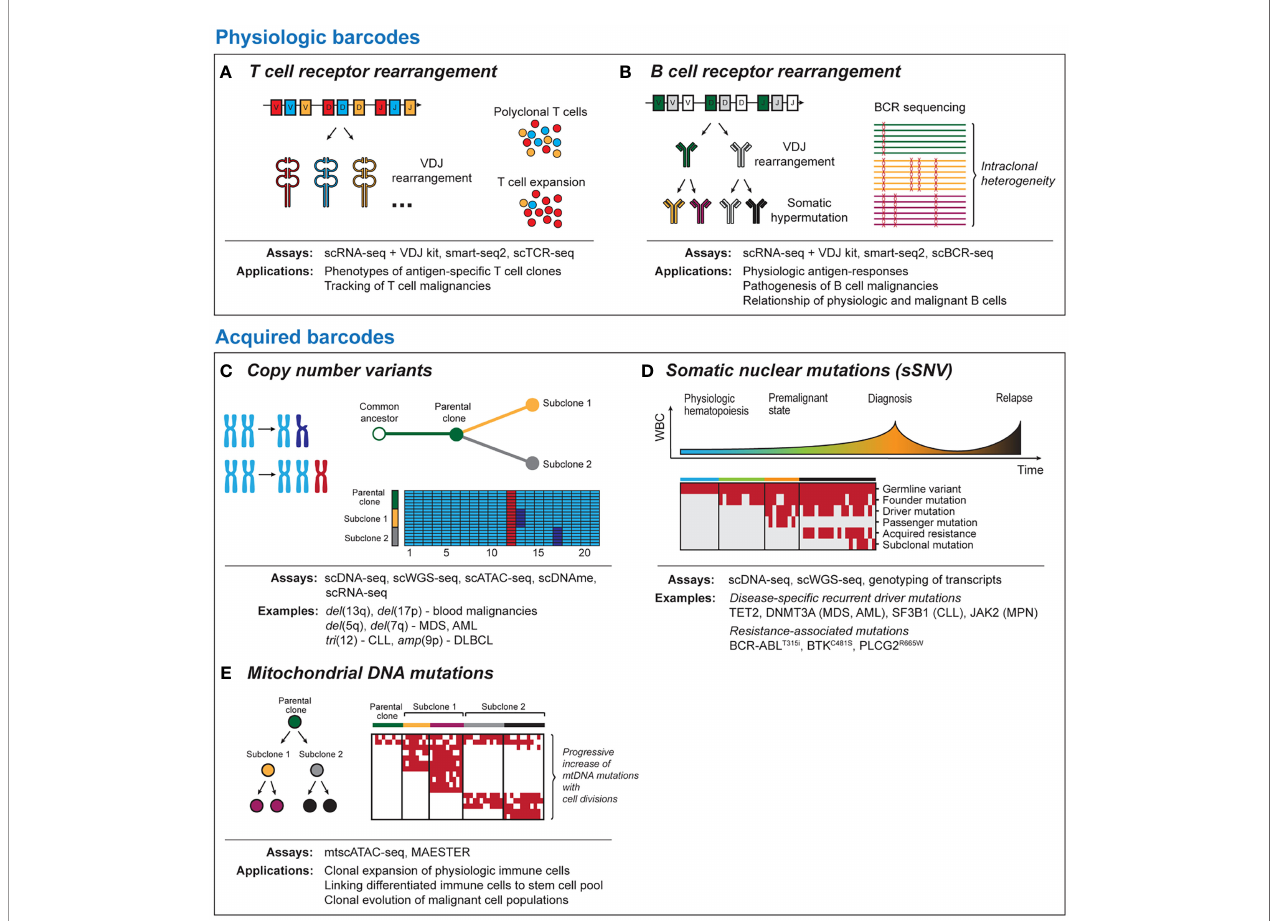
FIGURE 1 | Tool kits for lineage tracing with single-cell sequencing. Physiologic barcodes (A) T cell receptor (TCR) sequencing detects clonal expansion of T cells based on VDJ rearrangement and junctional diversi fi cation. TCR can help to identify and phenotype antigen-speci fi c T cells or track malignant T cells. (B) B cell receptor (BCR) sequences arise due to VDJ rearrangement and ongoing somatic hypermutation. BCR can provide insight into physiological antigen responses and intraclonal heterogeneity in post-germinal B cell malignancies. Both BCR and TCR are best read out with RNA-based single-cell platforms due to the high number of BCR/TCR mRNA templates per cell. Acquired barcodes (C) Chromosomal copy number variants (CNV) are common aberrations in blood malignancies. CNV can provide robust signals with DNA- and RNA-based sequencing platforms that allow to dissect subclonal structure of cancer and can be detected using most single- cell sequencing platforms. (D) Somatic nuclear mutations (single somatic-nucleotide variant, sSNV) can track clonal evolution in cancer longitudinally. Different classes of somatic mutations are distinguished such as germline variants, cancer initiating mutations, mutations associated with therapeutic resistance and sporadic mutations unrelated to the disease pathogenesis. (E) Mitochondrial DNA mutations are progressively acquired as cells divide. This allows to link physiologic or malignant cells to a common ancestor and to resolve phylogeny. As coverage of mitochondrial transcripts tends to be incomplete, they can be best read out from DNA-based sequencing platforms. scDNA-seq, single-cell DNA sequencing; scWGS-seq, single-cell whole genome sequencing; scATAC-seq, single-cell Assay for Transposase-Accessible Chromatin with high-throughput sequencing; scDNAme, single-cell sequencing of DNA methylation; scRNA-seq, single-cell RNA sequencing; mtscATAC-seq, mitochondrial scATAC-seq; scBCR-seq, single-cell B cell receptor sequencing; scTCR-seq, single-cell T cell receptor